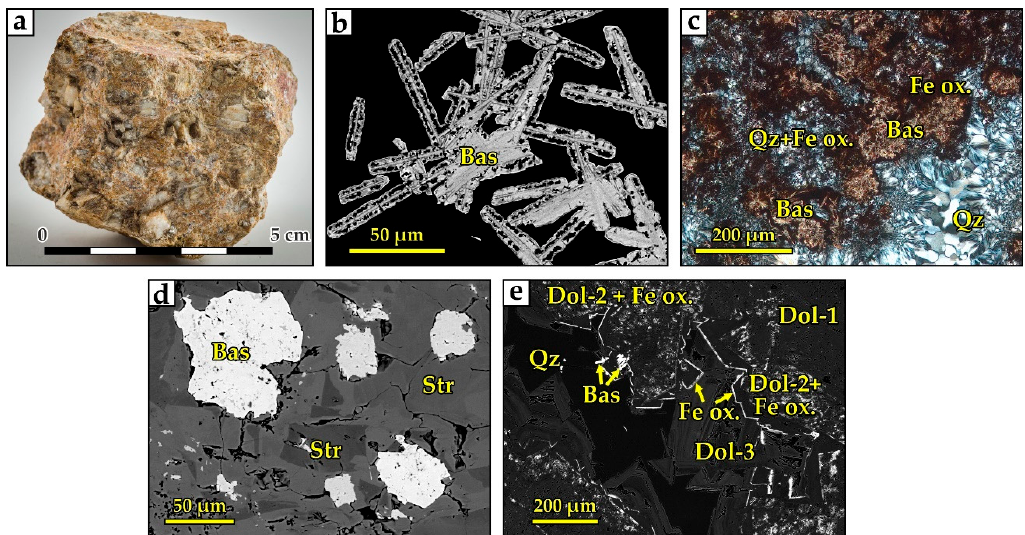
Figure 14. ( a ) A sample of a magnesiocarbonatite breccia with a quartz–bastnäsite matrix. ( b ) Crystals of bastnäsite. ( c ) Bastnäsite, surrounded by quartz. ( d ) Bastnäsite pseudomorphs after ancylite. ( e ) Spongy dolomite Dol-1 from the breccias, with rims of Dol-2 and inclusions of iron oxides, overgrown by the zoned dolomite Dol-3. Photomicrographs ( b ), ( d ), ( e ) in backscattered electrons (BSE images) and ( c ) in transmitted cross-polarized light.